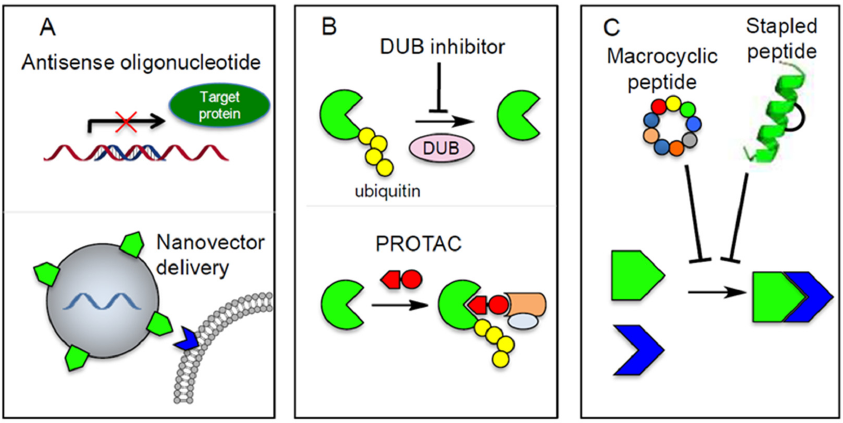
Figure 6. Other possible strategies for targeting downstream TGF- β signaling. ( A ) Targeting TGF- β signaling or its effectors (miRNA, LncRNAs) by antisense oligonucleotides. The stability and specific cell/tissue targeting of the oligonucleotide therapeutic molecules can be enhanced/mediated by nanoparticles. ( B ) Targeting TGF- β signaling inspired by harnessing the proteasomal machinery to degrade intracellular proteins. Deubiquitinating enzyme (DUB) inhibitor can enhance the degradation (or change the activity) of TGF- β signaling proteins (e.g., T β Rs, SMAD3, EMT-TFs) by inhibiting the deubiquitination process. Likewise, proteolysis-targeting chimeras (PROTACs) can induce the proteasomal-mediated degradation of target proteins (SMAD3, EMT-TFs) by recruiting target protein to specific E3 ligases. ( C ) Interfering protein-protein interaction by cyclic peptides (left) and stapled peptides